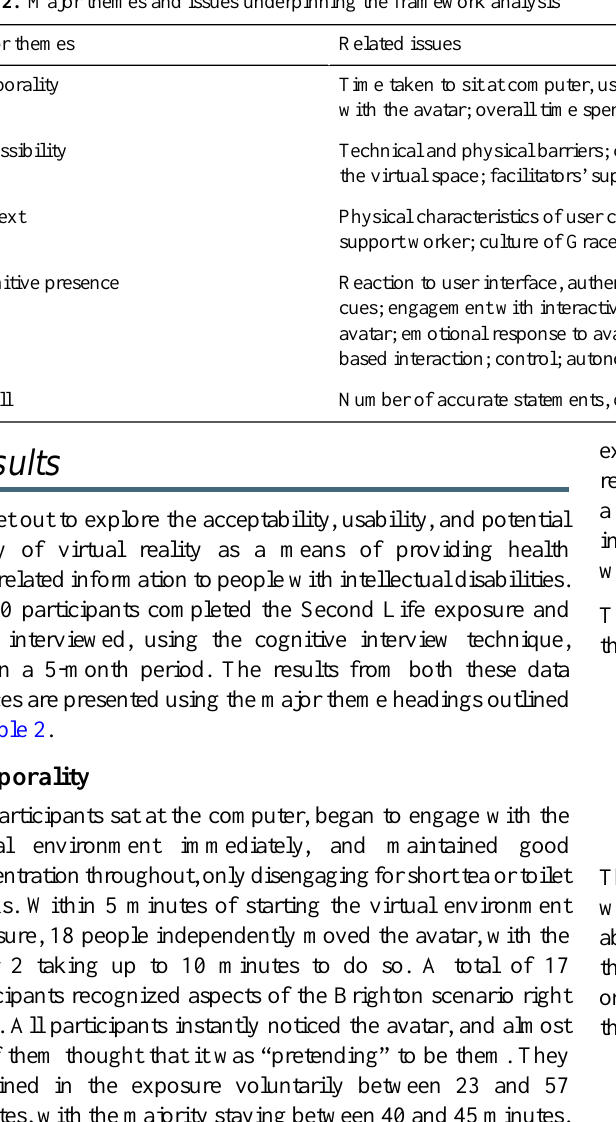
Table 2. Major themes and issues underpinning the framework analysis